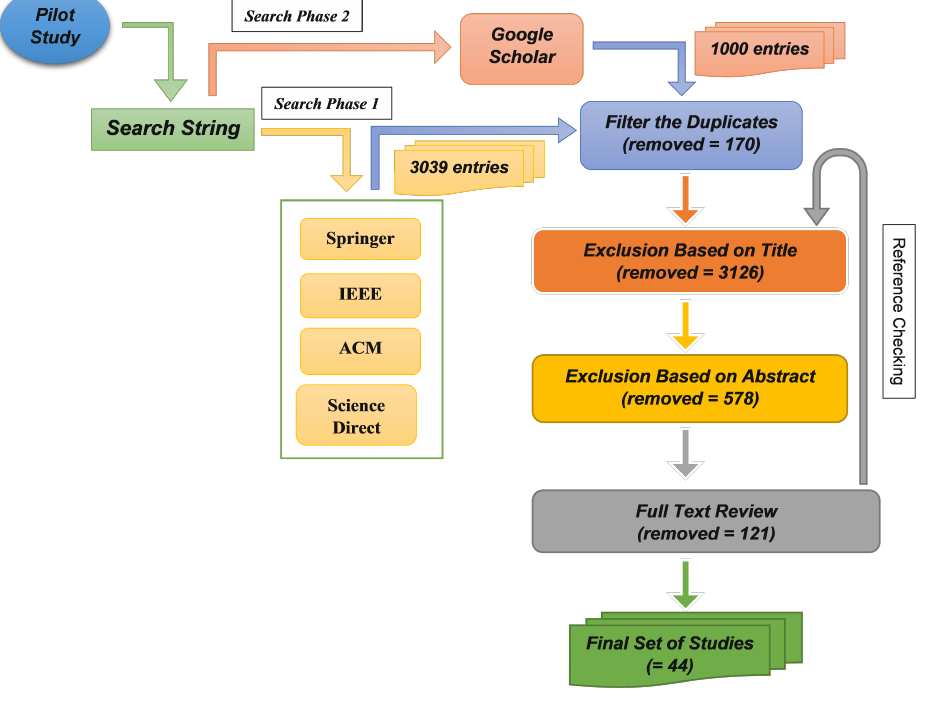
Figure 2. Systematic Literature Review